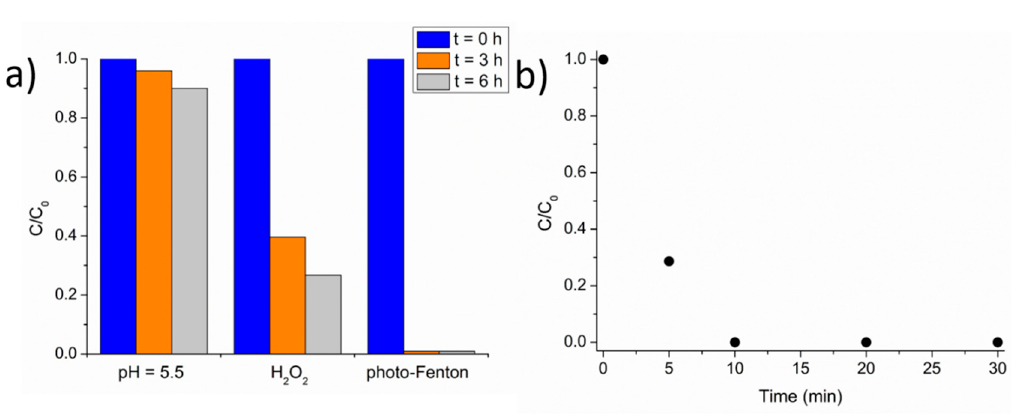
Figure 5. ( a ) Relative caffeine concentration evolution with time, under irradiation in different conditions. Initial caffeine concentration 5 mg L − 1 ; BBS-HA added 0.1 g L − 1 . Additional reagents: histograms labelled H 2 O 2 , addition of 1.5 × 10 − 3 mol L − 1 of H 2 O 2 ; histograms labelled photo-Fenton, addition of 1.5 × 10 − 3 mol L − 1 of H 2 O 2 and 5.0 mg L − 1 of iron(II). ( b ) Relative caffeine concentration evolution with time in photo-Fenton conditions. Initial caffeine concentration 5 mg L − 1 ; BBA-HA concentration 0.1 g L − 1 ; concentration of H 2 O 2 1.5 × 10 − 3 mol L − 1 and concentration of iron(II) 5.0 mg L − 1 .